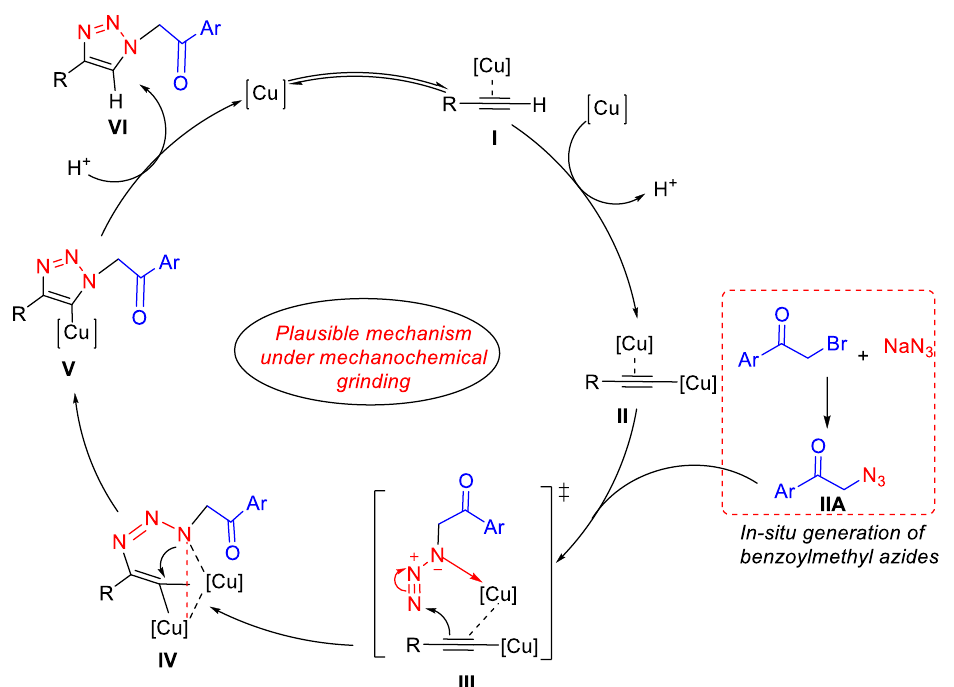
Figure 5. Plausible reaction pathway of the Huisgen cycloaddtion.